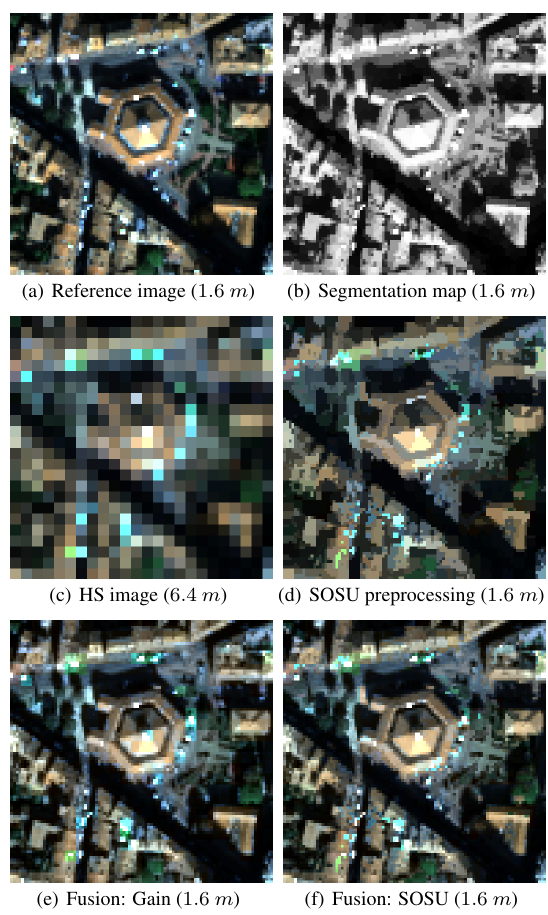
Figure 4. "Halle" dataset (spatial resolutions in brackets)